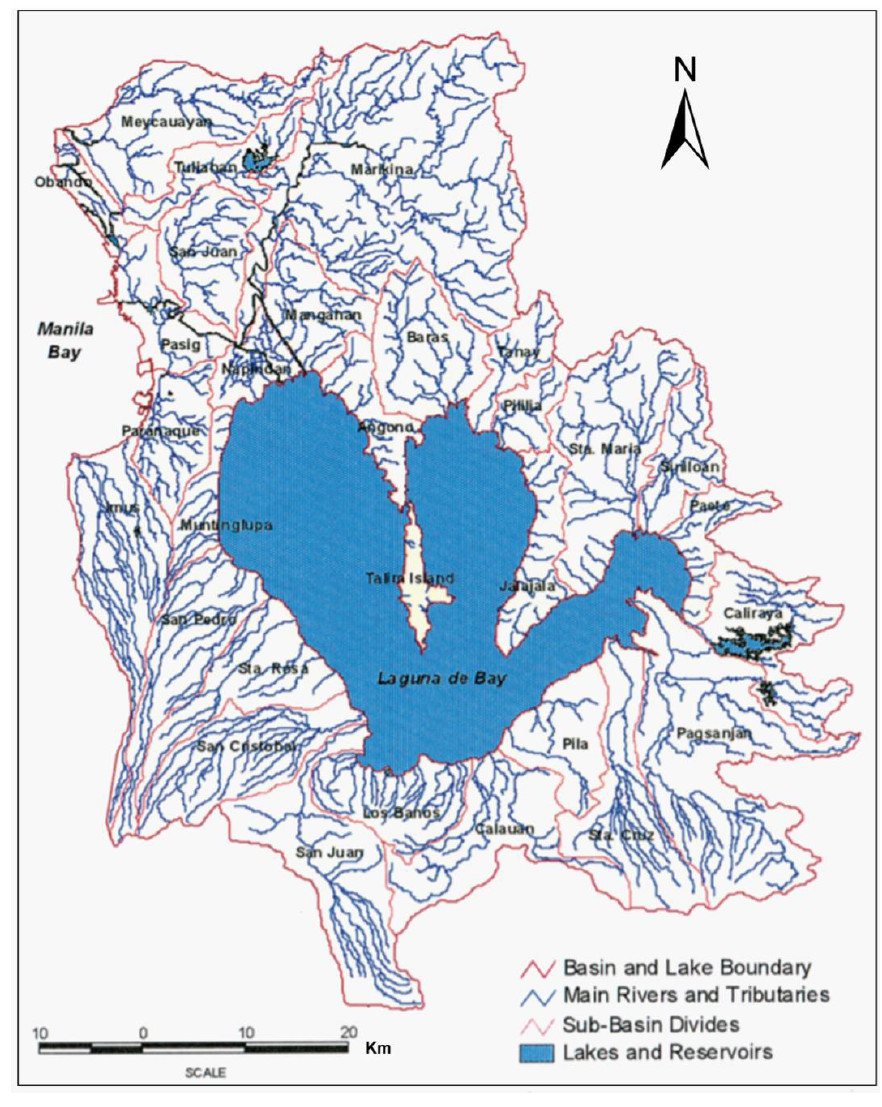
Figure 2. Location of the municipalities of the tributary rivers of the Laguna de Bay [54,55].